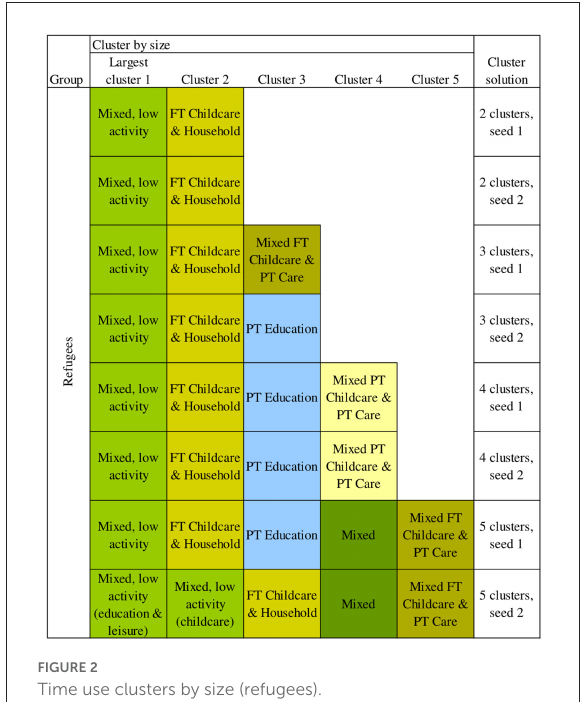
FIGURE3 Time use clusters by size (natives).